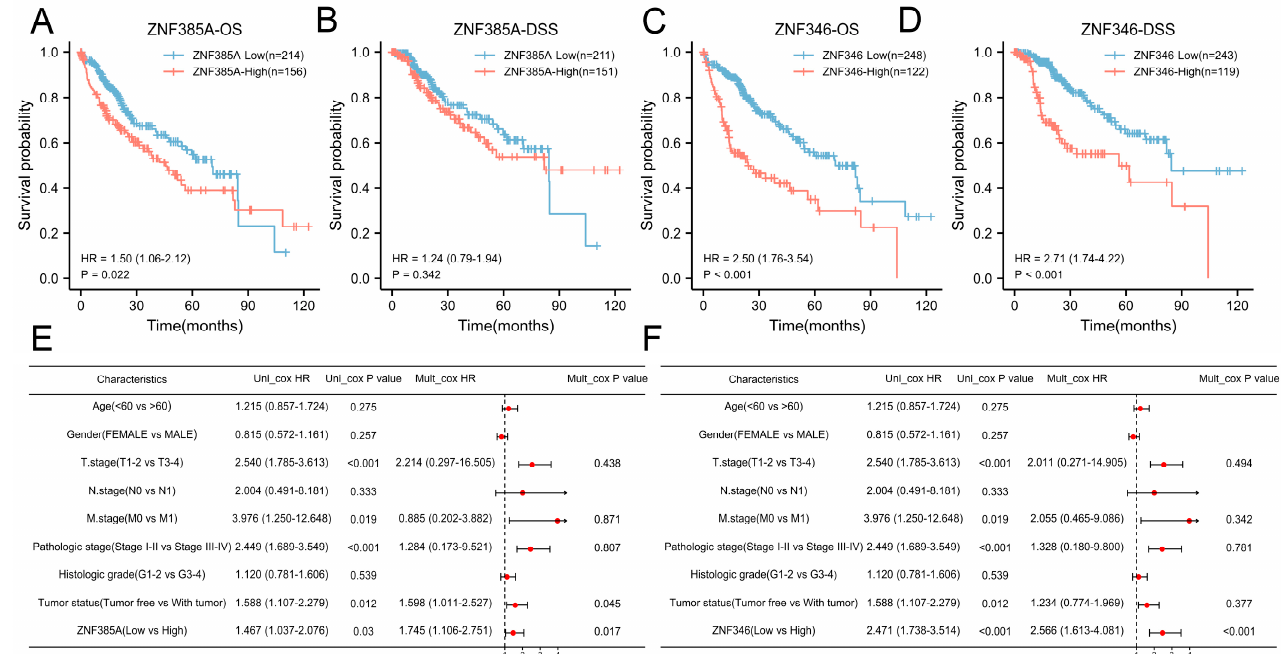
Figure 3. ZNF385A and ZNF346 predict a poorer prognosis in HCC. ( A – D ) Survival curves of OS and DSS between high and low ZNF385A , and ZNF346 expression subgroups in HCC. ( E , F ) Univariate and multivariate Cox regression analyses of ZNF385A ( E ) and ZNF346 ( F ) for clinical factors.